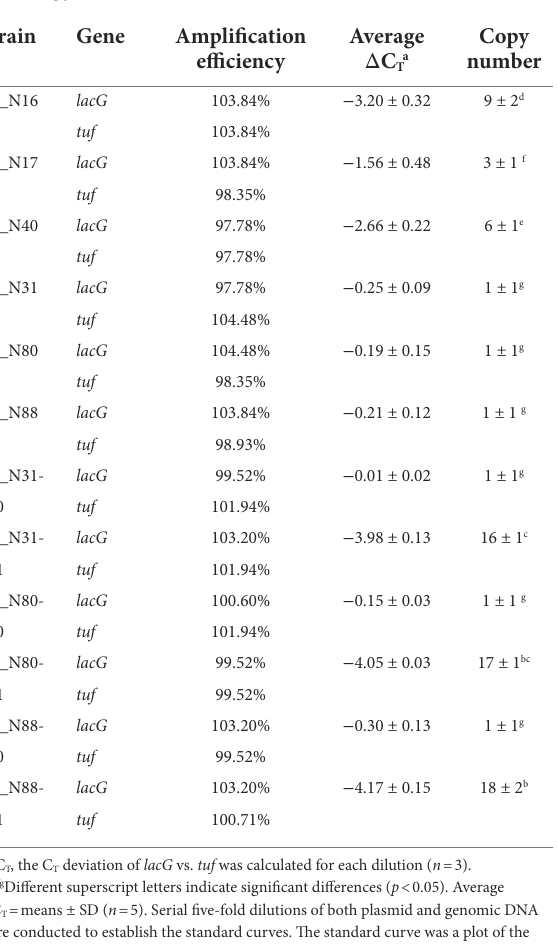
TABLE 3 Copy numbers of lac operon in exemplar L. casei strains from the high acid (HC) strains (LC_N16, 17, 40), recombinant strains